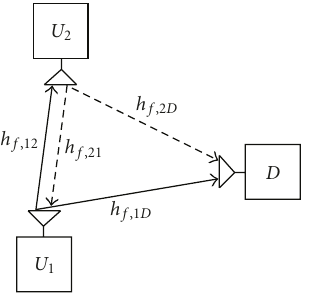
Figure 1: Cooperative system model.